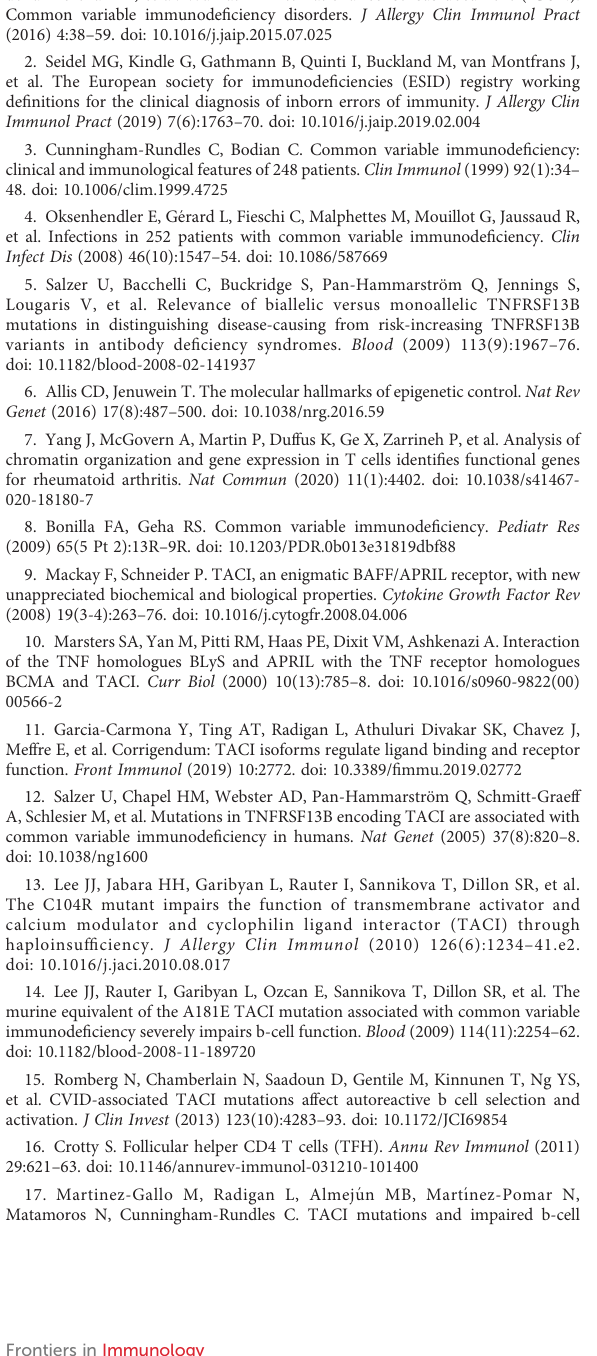
SUPPLEMENTARY FIGURE 4 pERK expression in unstimulated and stimulated naïve B cells from TACI mutation carriers. (A) Mean fl uorescence intensity (MFI) of pERK in unstimulated and with CD40L stimulated naïve B cells from affected and unaffected TACI mutation carriers and healthy donor. (B) Ratios of the MFI of I k B a after and without indicated stimulation. P-values (* P <0.05) derive from unpaired t-test calculated with GraphPad Prism 8. # n.s.: non-signi fi